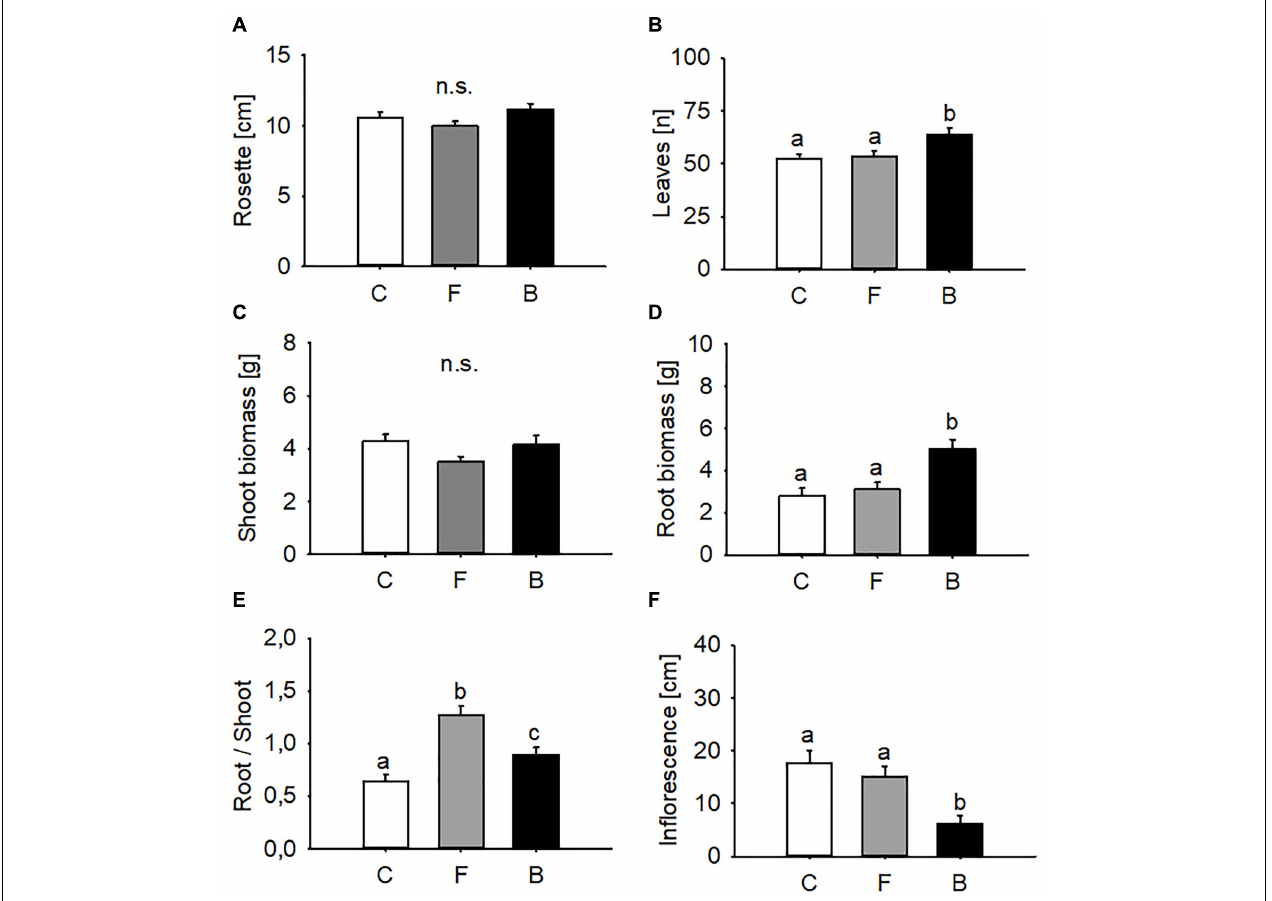
FIGURE 1 | Effects of B. bassiana on A. thaliana growth. Rosette diameter (A) , numbers of leaves (B) , shoot biomass (C) , root biomass (D) , root/shoot ratio (E) , and inflorescence length (F) in B. bassiana colonised (F, FRh2 and B, BG11) and control (C) plants. Error bars represent the standard error of the mean ( N = 20), bars with different letters differ significantly ( P <